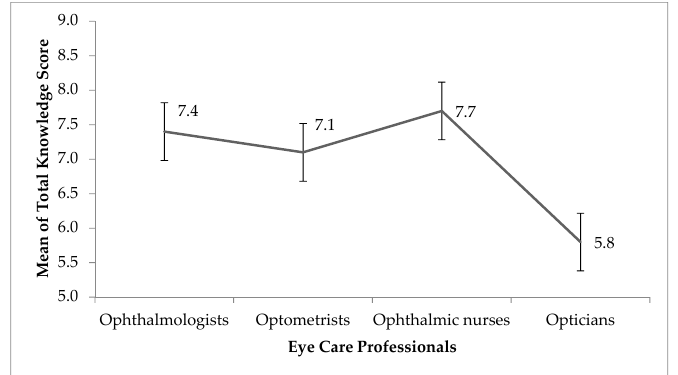
Figure 1. The mean knowledge score for each eye care profession in the survey. Error bars represent standard error of the mean. In the multivariable analysis, we found that, after adjusting for all cofounders in the final model, eye care profession (job title) was the only factor associated with knowledge of risk towards COVID- 19 (adjusted coefficient, -0.182, 95% Confidence Interval -0.601, -0.22; p < 0.0001) (Table 3). Table 3. Multiple regression of factors associated with knowledge related to COVID-19 among eye care professionals in Nigeria during the lockdown.